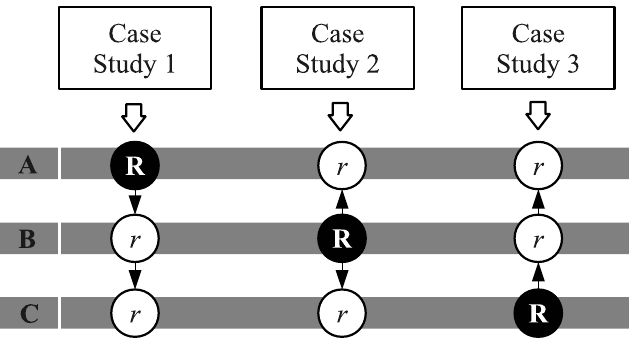
Fig. 8. The results of two additional case studies (R) are translated to results (r) relevant for industrial partners A, B and